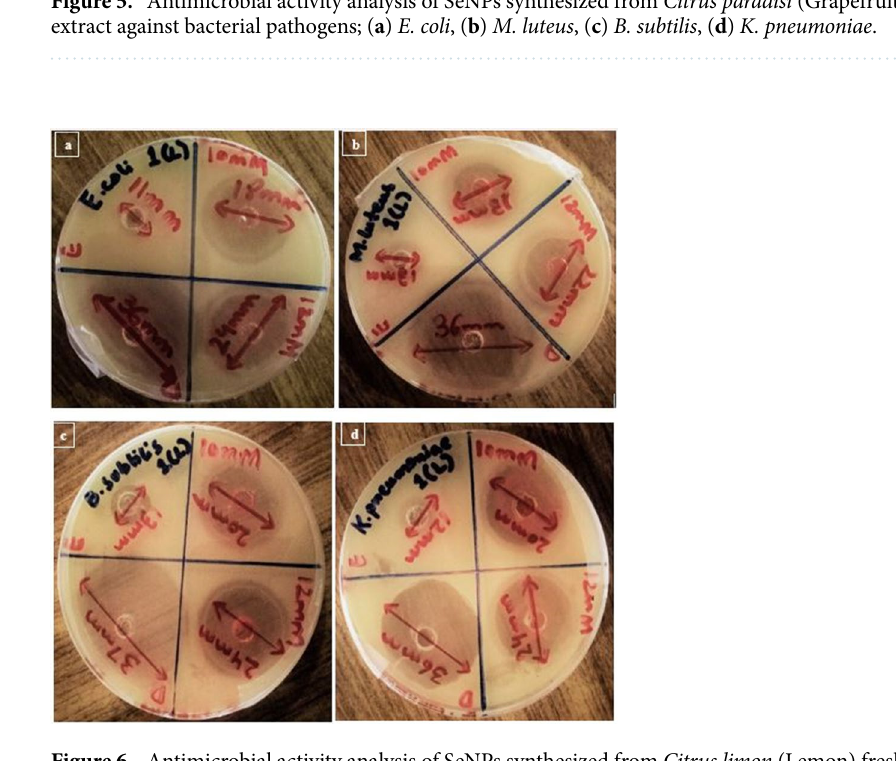
Figure 6. Antimicrobial activity analysis of SeNPs synthesized from Citrus limon (Lemon) fresh juice extract against bacterial pathogens; ( a ) E. coli , ( b ) M. luteus , ( c ) B. subtilis , ( d ) K. pneumoniae